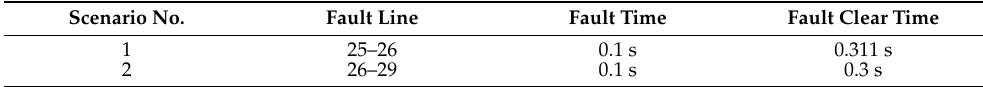
Table 8. Contingency scenarios of IEEE 39 bus system.